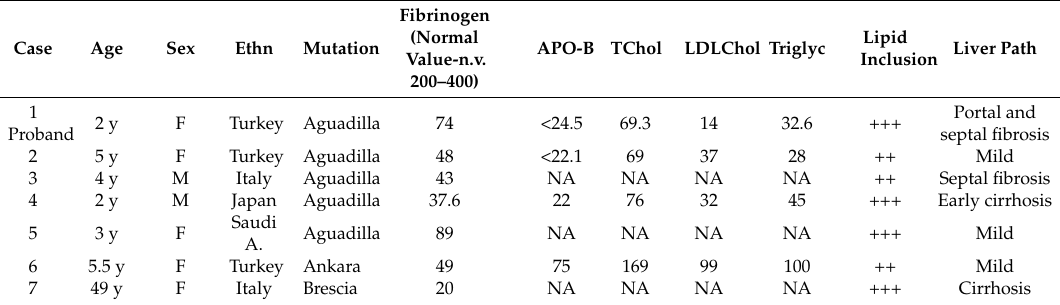
Table 1. Ethnic, molecular genetics, biochemical, and morphological findings in seven fibrinogen storage disease (FSD)